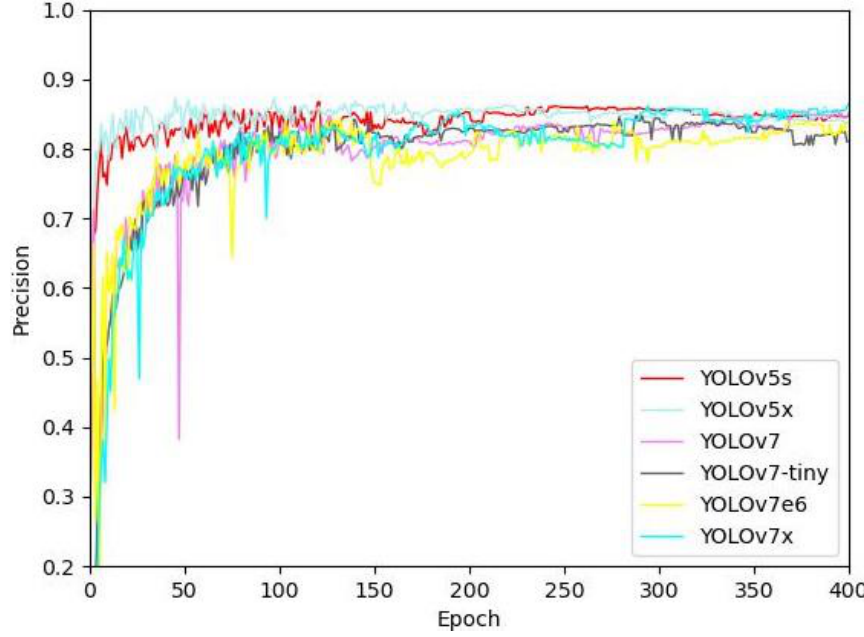
Figure 5. Comparison of training precision.